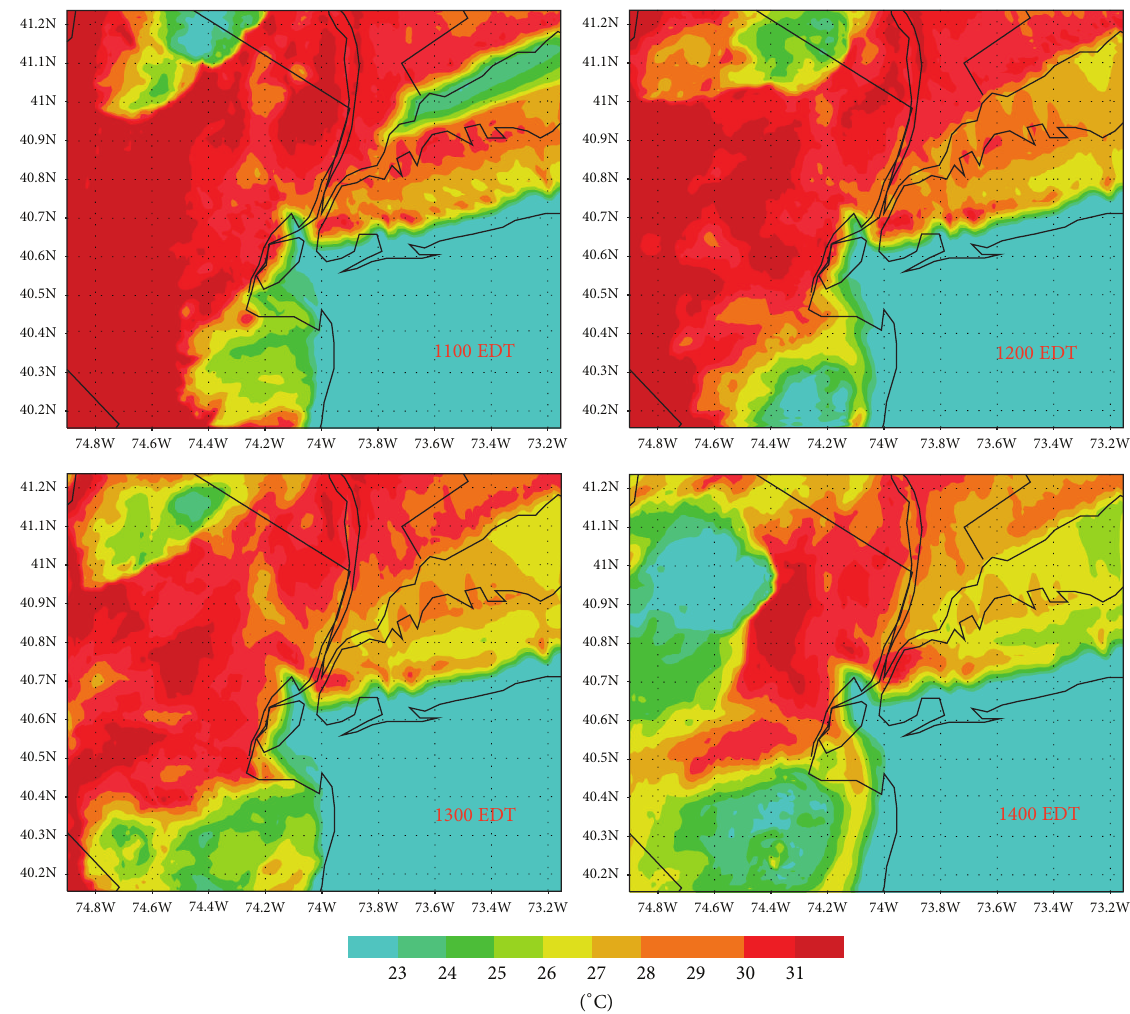
Figure 7: Temperature over the NYC region 2 m from the surface at different local standard